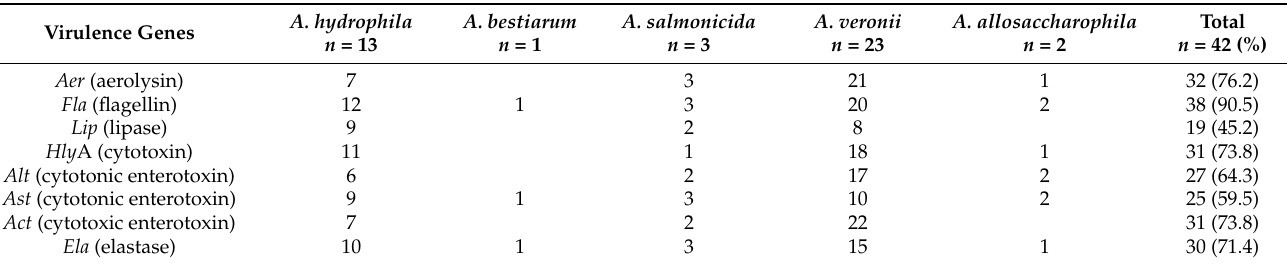
Table 4. Prevalence of virulence genes in Aeromonas